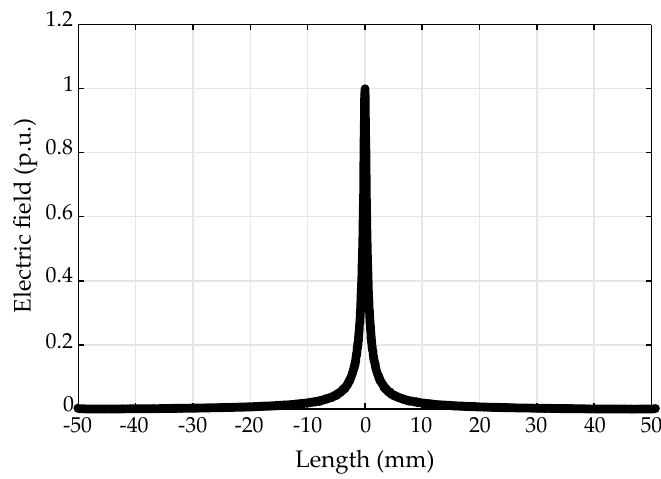
Figure 3. Electric field distribution along insulator surface. Here, 0mm represents the center of the top surface of the insulator sample while ± 50mm the edges of it. The presented values are normalised based on the maximum computed value.